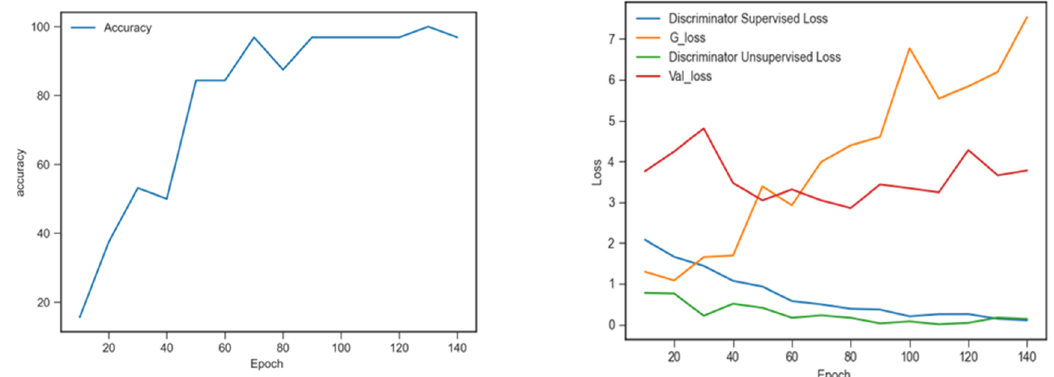
Figure 7. Classification performance on BreakHis dataset: accuracy ( left ), training loss ( right ).